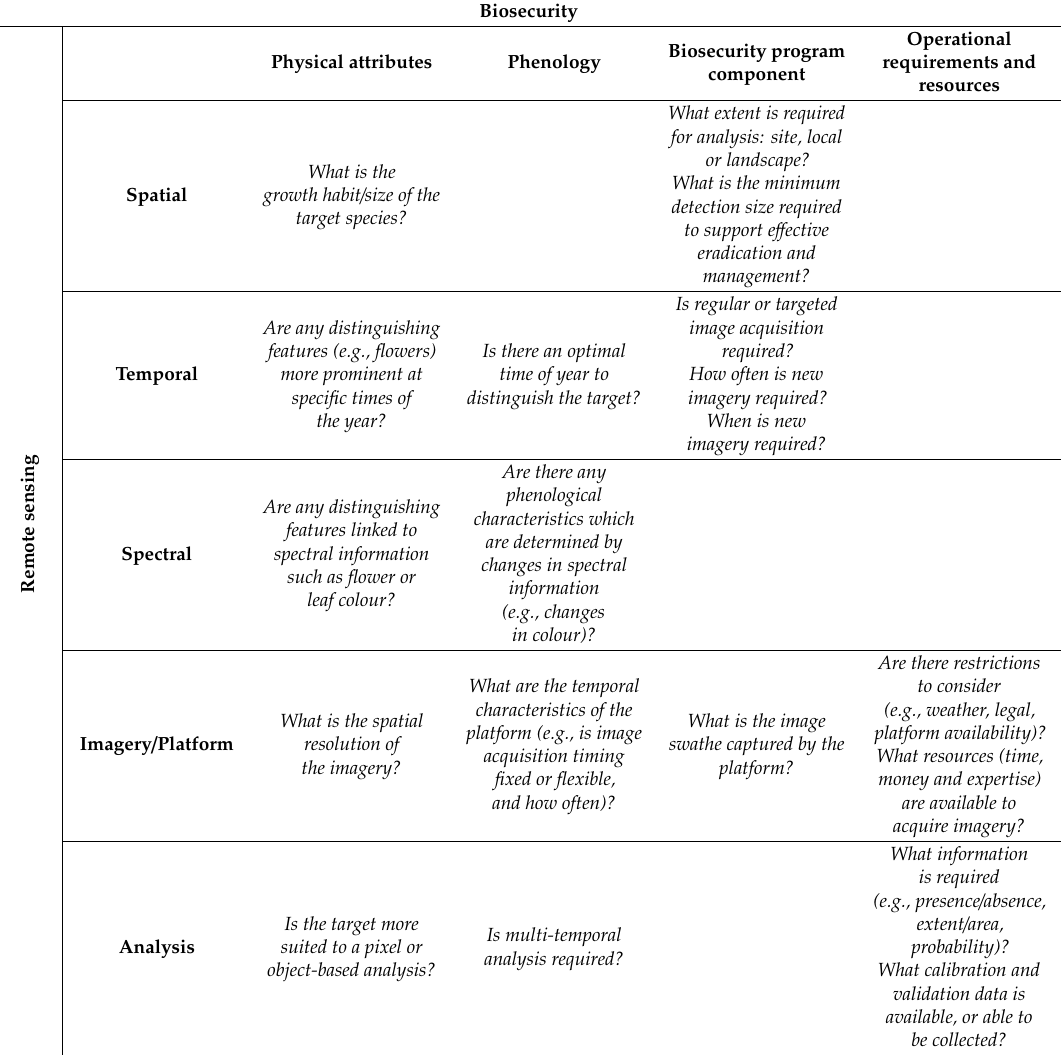
Table 3. Sample Remote Sensing Technology and Analytical Method Matrix (TAMM), a component of the Weed Aerial Surveillance Program (WASP) framework, with example key considerations to guide development of image analysis workflows and